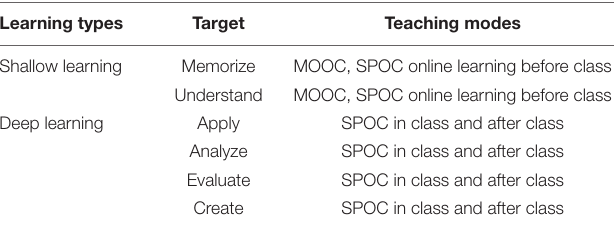
TABLE 2 | Comparison of learning types between Massive Open Online Course (MOOC) and Small Private Online Course (SPOC). Learning